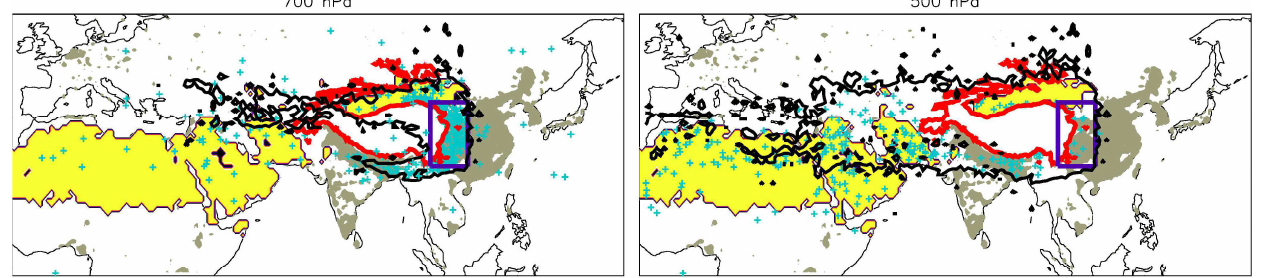
Fig. 6. Back trajectories originating east of the plateau at 700hPa (left) and 500hPa (right) for April 2010. Violet box indicates the starting point area of the back trajectories. Yellow areas are the dust regions considered as potential sources. Grey areas are total black carbon emissions greater than the threshold mentioned in the text. Black contour surrounds the regions where around 99% of the back trajectory particles are found, while the light-blue points are the irreversible PBL crossing points. Red contour reports the 700hPa level to identify the presence of the Himalayan